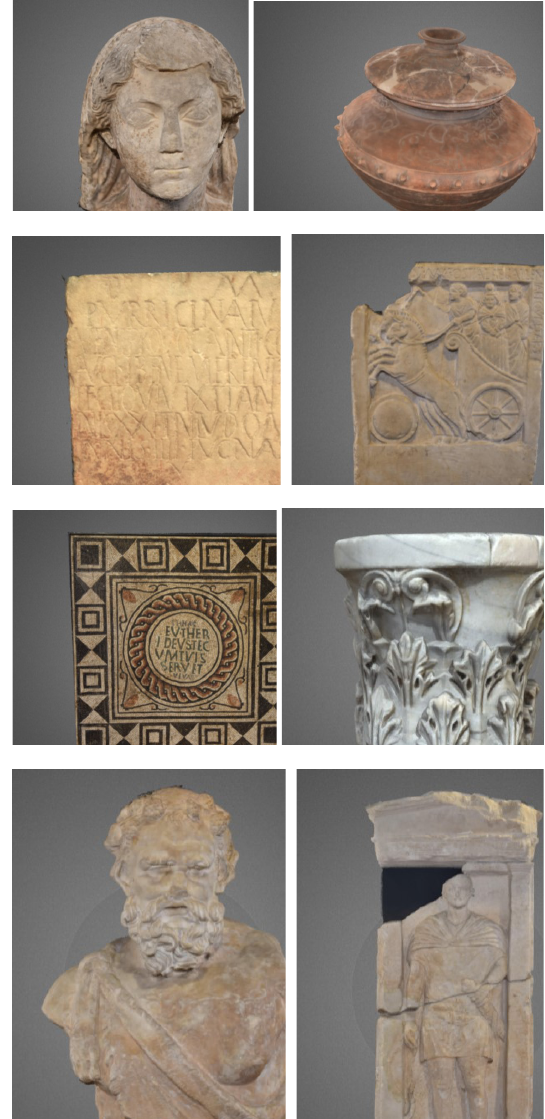
Figure 15. Artifacts from Museo Civico